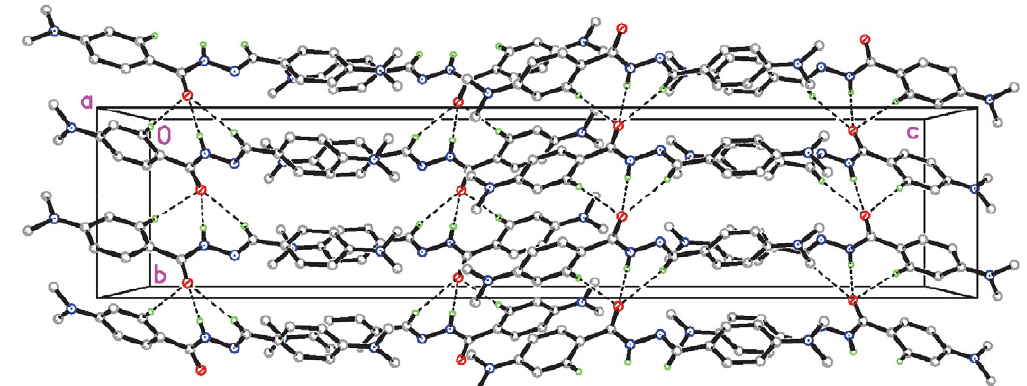
Figure 4. The packing diagram of 1 . Hydrogen bonding interactions are shown as dashed lines.